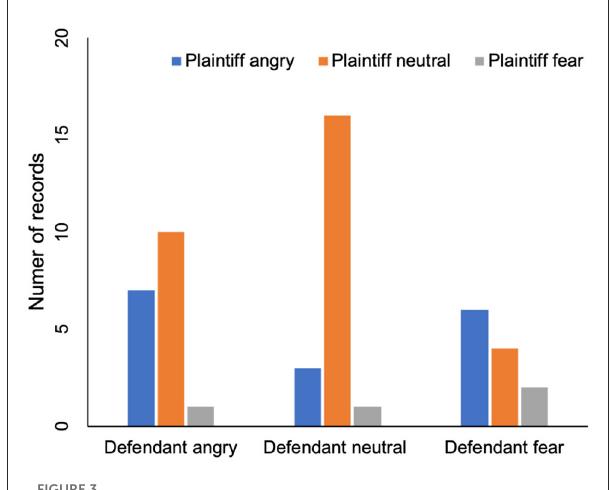
FIGURE3 The influence of plaintiff’s emotion on defendant’s emotion.